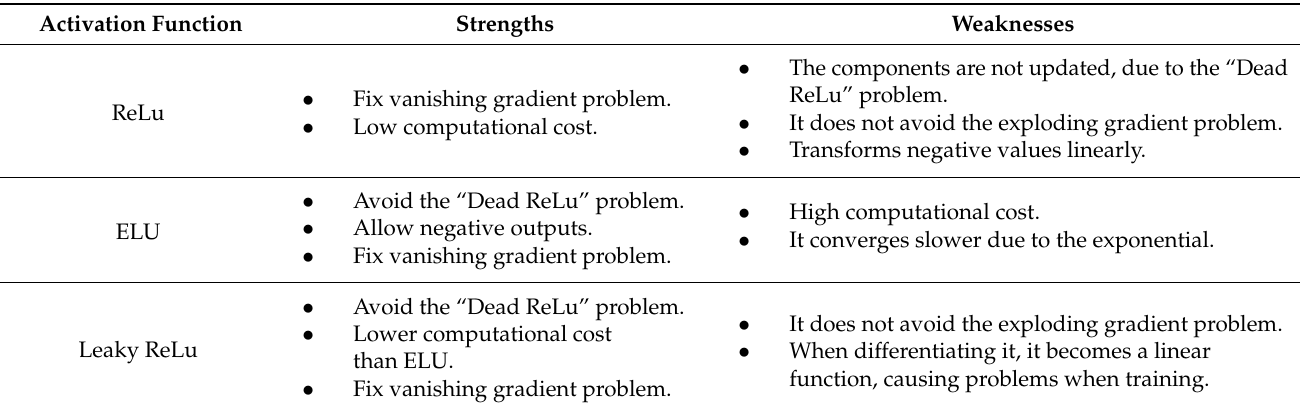
Table 2. Strengths and weaknesses of the ReLu, ELU, Leaky ReLu activation functions.